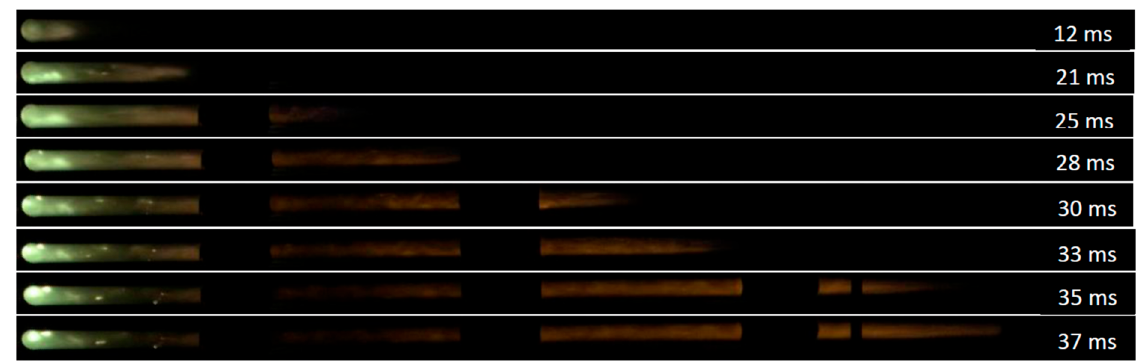
Figure 12. 10% methane–air flame propagation in the tube with a 70% circular opening obstacle positioned 1.2 m from the ignition source.